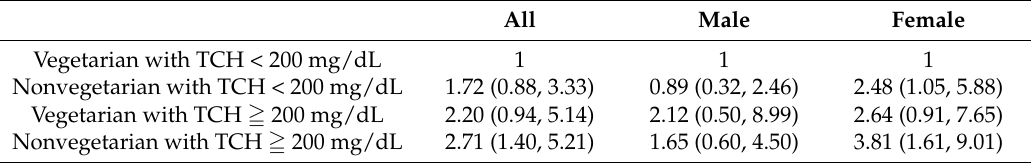
Table 5. Hazard ratio of diet with normal and high total cholesterol concentration for gallstone disease. All Male Female Vegetarian with TCH < 200 mg/dL 1 1 1 Nonvegetarian with TCH < 200 mg/dL 1.72 (0.88, 3.33) Vegetarian with TCH (cid:61) 200 mg/dL Nonvegetarian with TCH (cid:61) 200